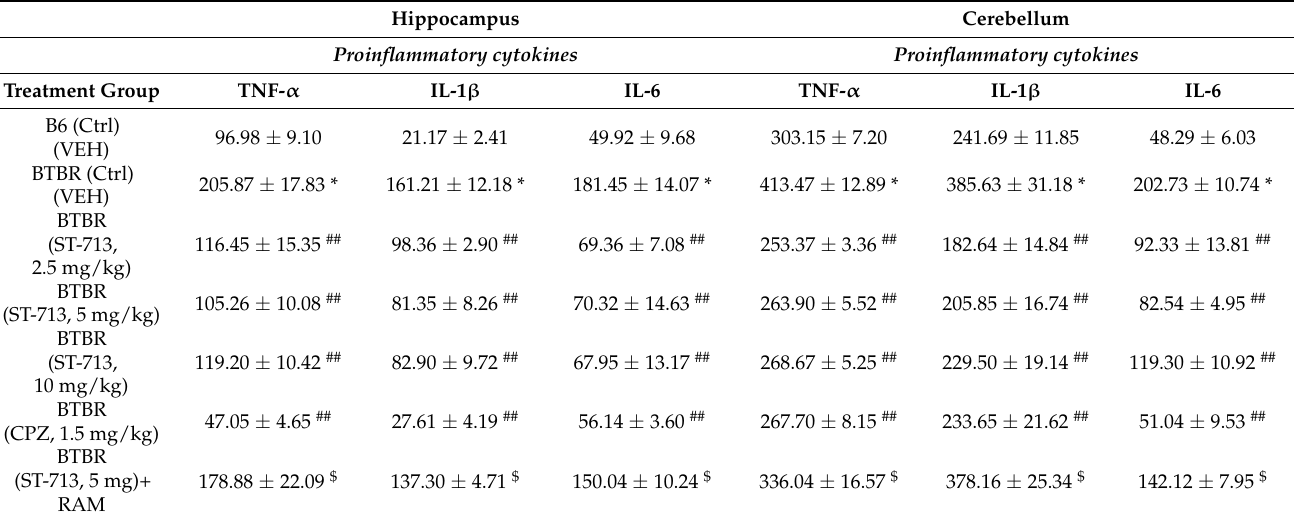
Table 1. ST-713 mitigated levels of hippocampal and cerebellar proinflammatory cytokines in BTBR mice. Hippocampus